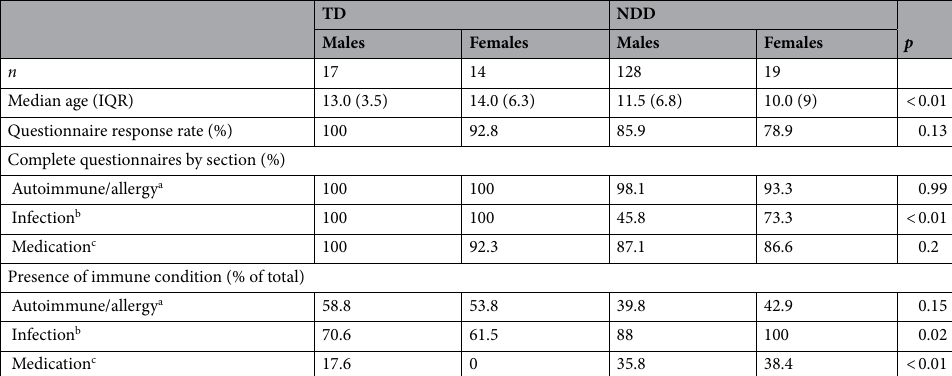
Table 1. Demographic overview of participants & child immune history questionnaire responses. IQR—interquartile range. a Autoimmune disease or allergy: allergy, asthma, allergic rhinitis, food